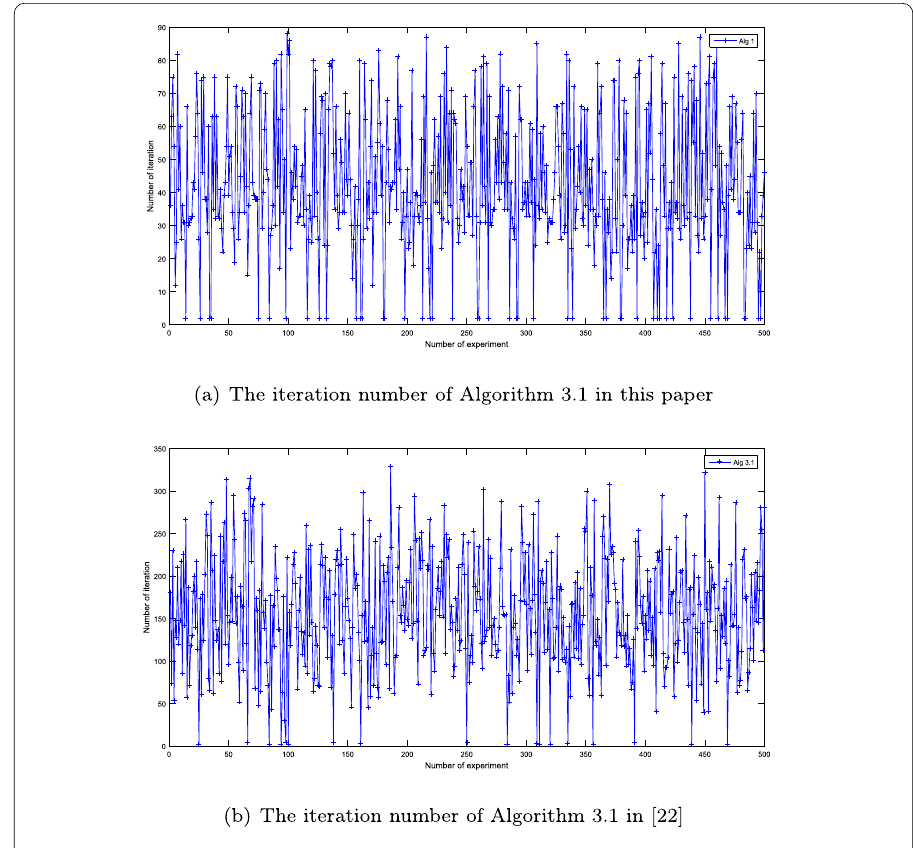
Figure 4 The iteration number of Algorithm 3.1 in this paper and Algorithm 3.1 in [23]